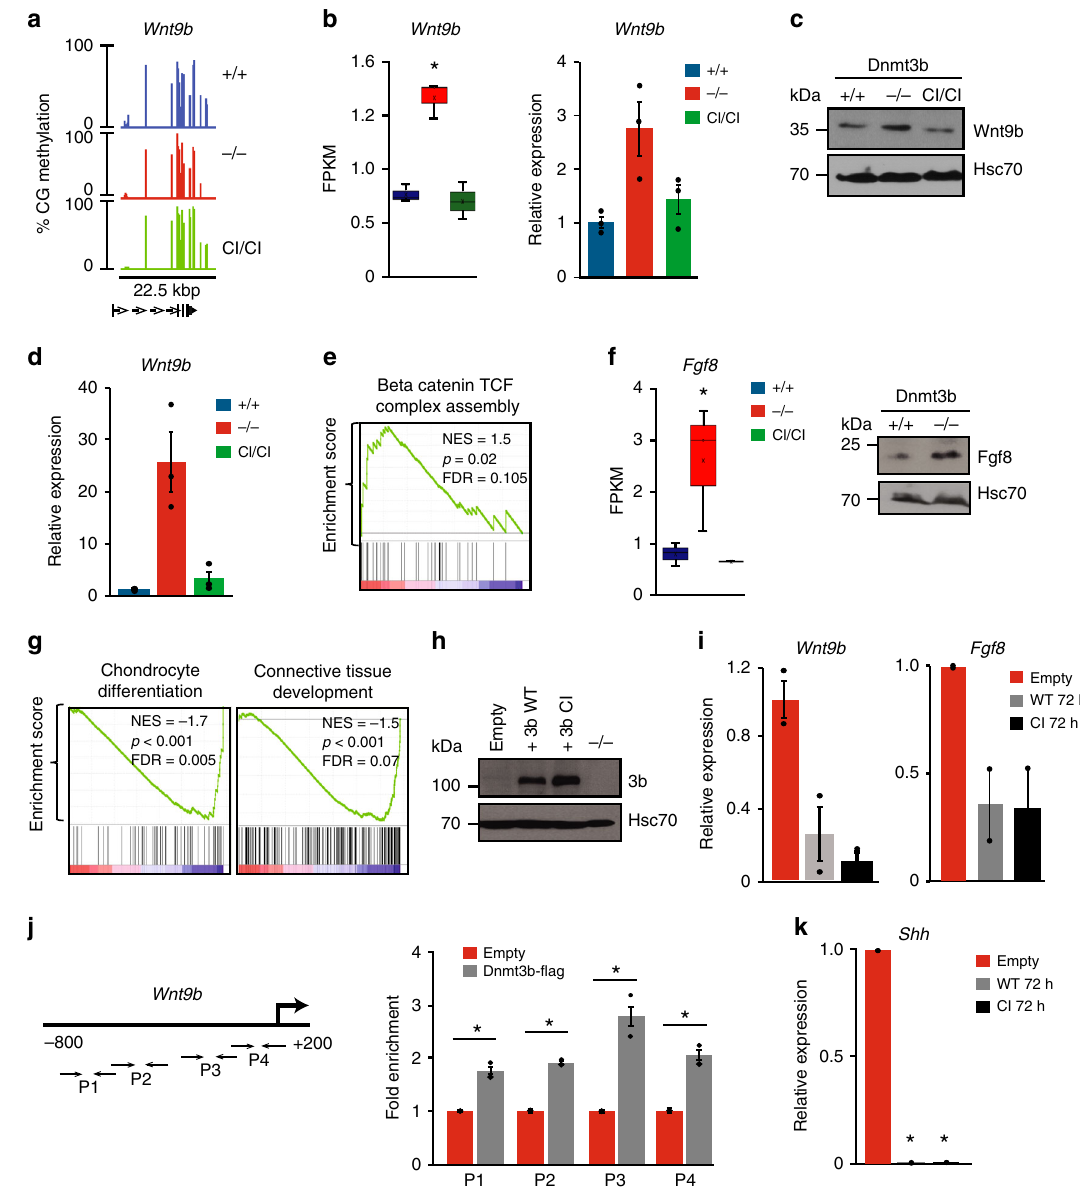
Fig. 7 Dnmt3b represses Wnt9b and Shh in vivo and in vitro. a Methylation of Wnt9b locus in E11.5 embryos of indicated genotypes determined by RRBS. b Wnt9b expression by RNA-seq ( n = 3; * p < 0.05 by DESeq; left) and real-time qRT-PCR ( n = 3; normalized to Gapdh ; right) in E11.5 embryos. Horizontal line represents median, bounds of box — likely range of variation and whiskers — min and max values. c Immunoblot of Wnt9b and Hsc70 levels in E11.5 embryos. d Wnt9b expression by real-time qRT-PCR in fetal brain of E11.5 embryos ( n = 3), normalized to Gapdh . e GSEA using RNA-seq data shows positive enrichment in Beta-catenin – TCF complex assembly in E11.5 Dnmt3b − / − embryos ( n = 3). Normalized enrichment scores (NES), false discovery rate (FDR) and p values are shown. f Left. Fgf8 expression by RNA-seq in Dnmt3b + / + , Dnmt3b − / − , and Dnmt3b CI/CI E11.5 embryos ( n = 3), * p < 0.05 (DESeq). Horizontal line represents median, bounds of box — likely range of variation and whiskers — min and max values. Right. Immunoblot analysis of Fgf8 levels in E11.5 embryos. g GSEA shows negative enrichment in developmental pathways in E11.5 Dnmt3b − / − embryos relative to Dnmt3b + / + ( n = 3). h Dnmt3b and Hsc70 expression in mouse Dnmt3b − / − T cell lymphoma cells ( − / − ) 72 h after transduction with lentiviruses expressing control vector (empty), Dnmt3b WT (3b WT), Dnmt3b CI (3b CI) as analyzed by immunoblot. i Real-time qRT-PCR analysis of Wnt9b and Fgf8 expression in samples prepared as in h . Average of two independent experiments normalized to β -actin . j Left: Schematic of mouse Wnt9b promoter with position of primers (arrows): P1: − 763/ − 582 bp, P2: − 603/ − 411 bp; P3: − 342/ − 127 bp; P4: − 143/ + 36 bp relative to TSS. Right: Real-time qRT-PCR on DNA immunoprecipitated with anti- FLAG antibody from Dnmt3b − / − lymphoma cells expressing FLAG tagged Dnmt3b WT or empty vector. Data are shown as averaged fold enrichment over empty vector ( n = 2), * p < 0.001 (two-tailed Student ’ s t -test). Assay was performed in triplicates and normalized to the input DNA. k Shh expression by real-time qRT-PCR in samples described in h . Averaged data of two independent experiments were normalized to β -actin , * p < 0.001 (two-tailed Student ’ s t -test). Data in fi gures b , d , i , j, and k are presented as means ± SEM. Source data are provided as a Source Data fi